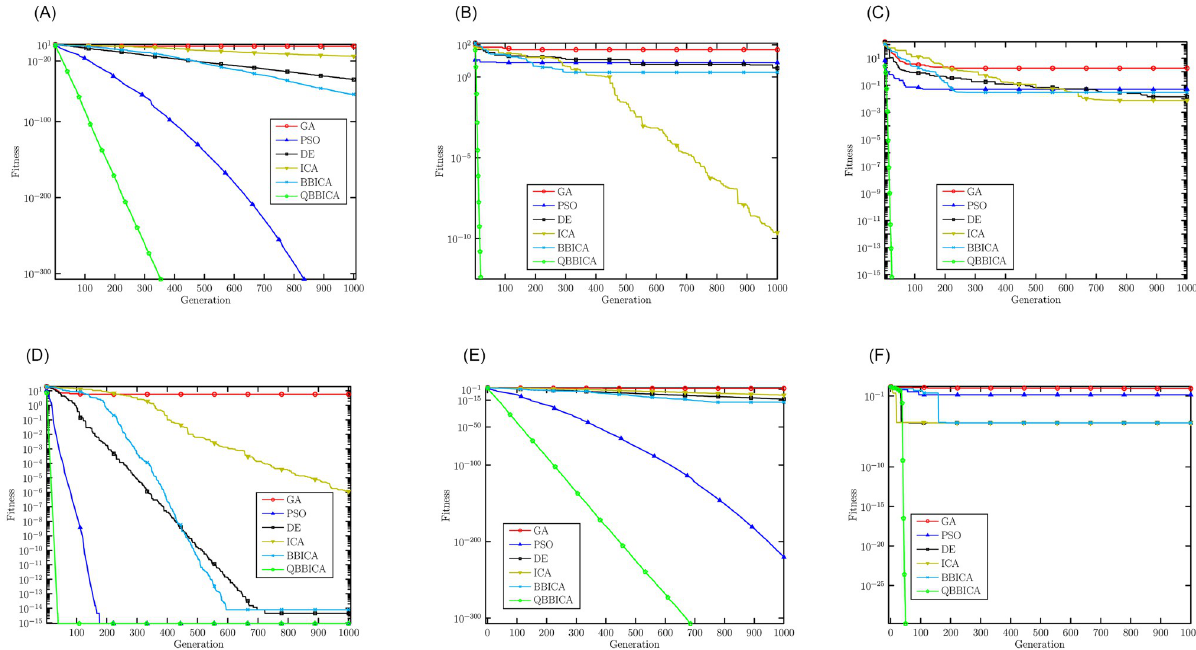
Fig 3. Convergence curves of different algorithms on the benchmark functions. (a) Sphere, (b) Rastrigin, (c) Griewangk, (d) Ackley, (e) Alpine, (f) Pathologic.